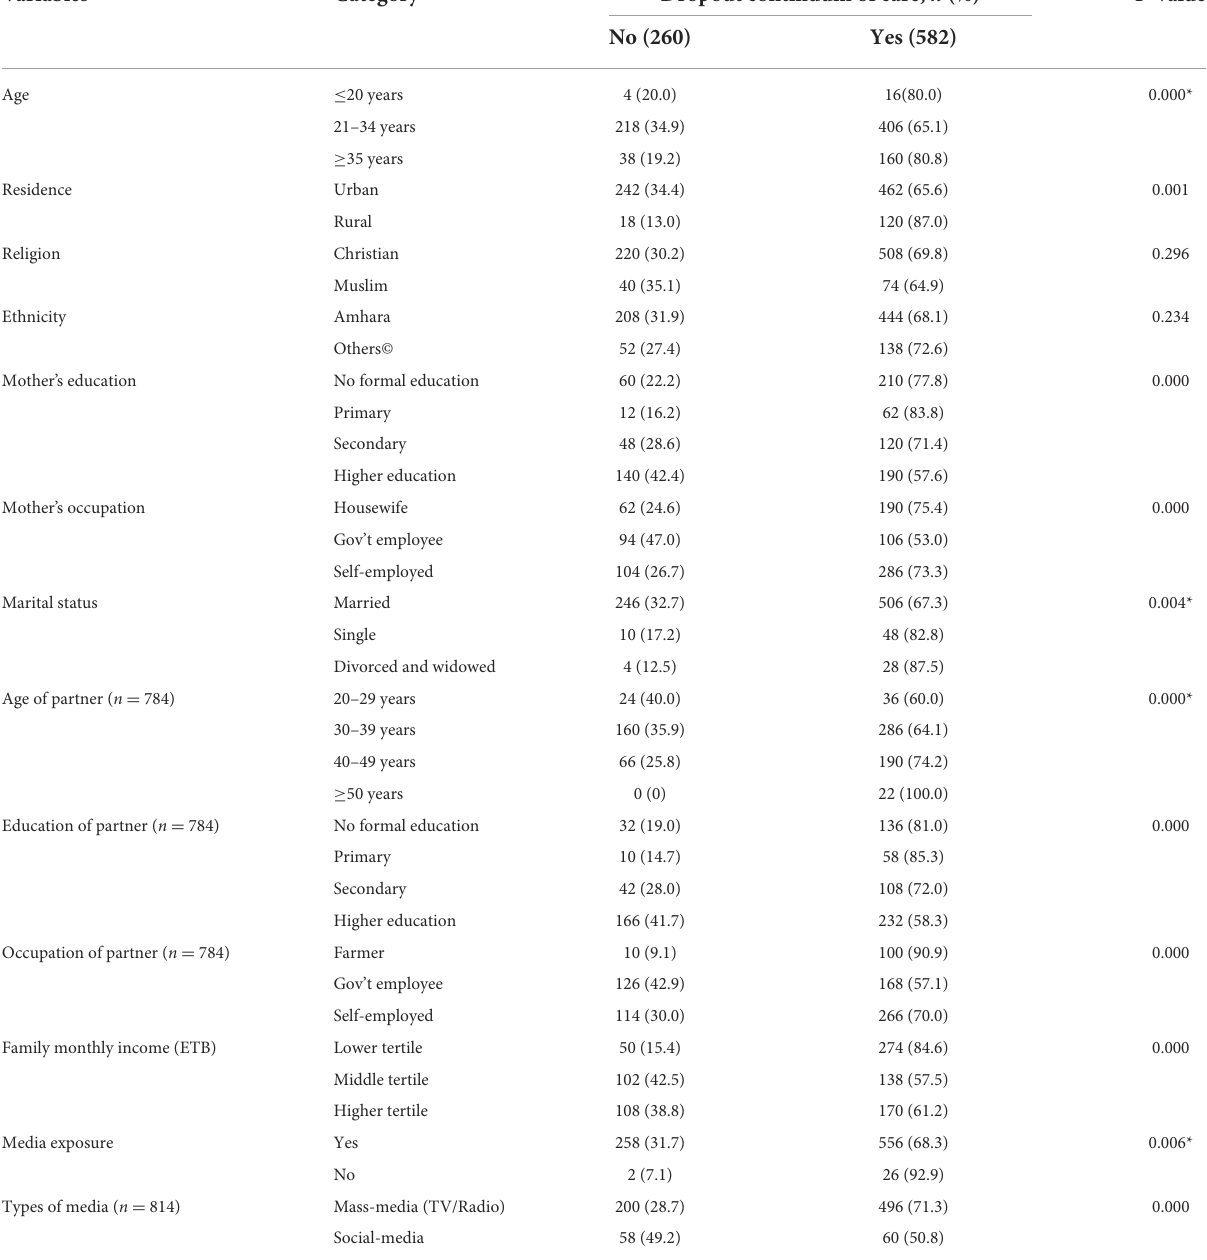
TABLE 1 Distribution of sociodemographic data by dropout from continuum of care in Debre Berhan town, northeast